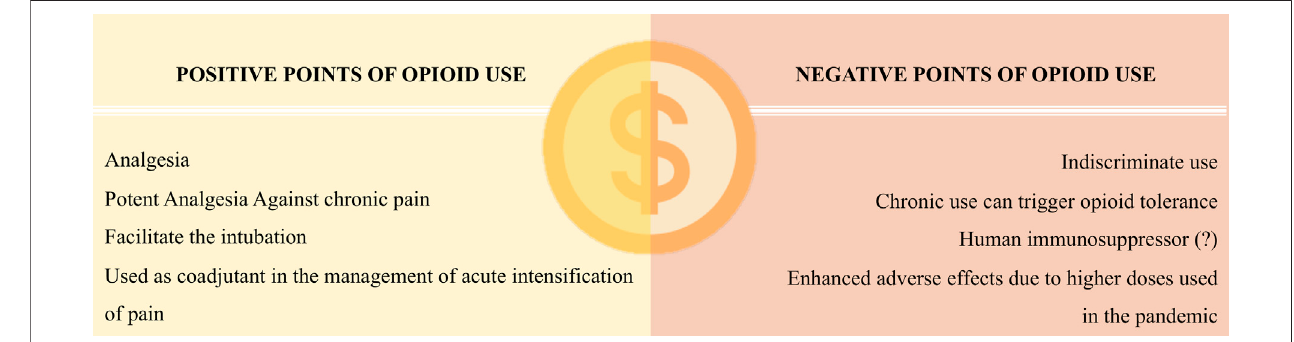
FIGURE 3 | Main risks and bene fi ts associated with the use of